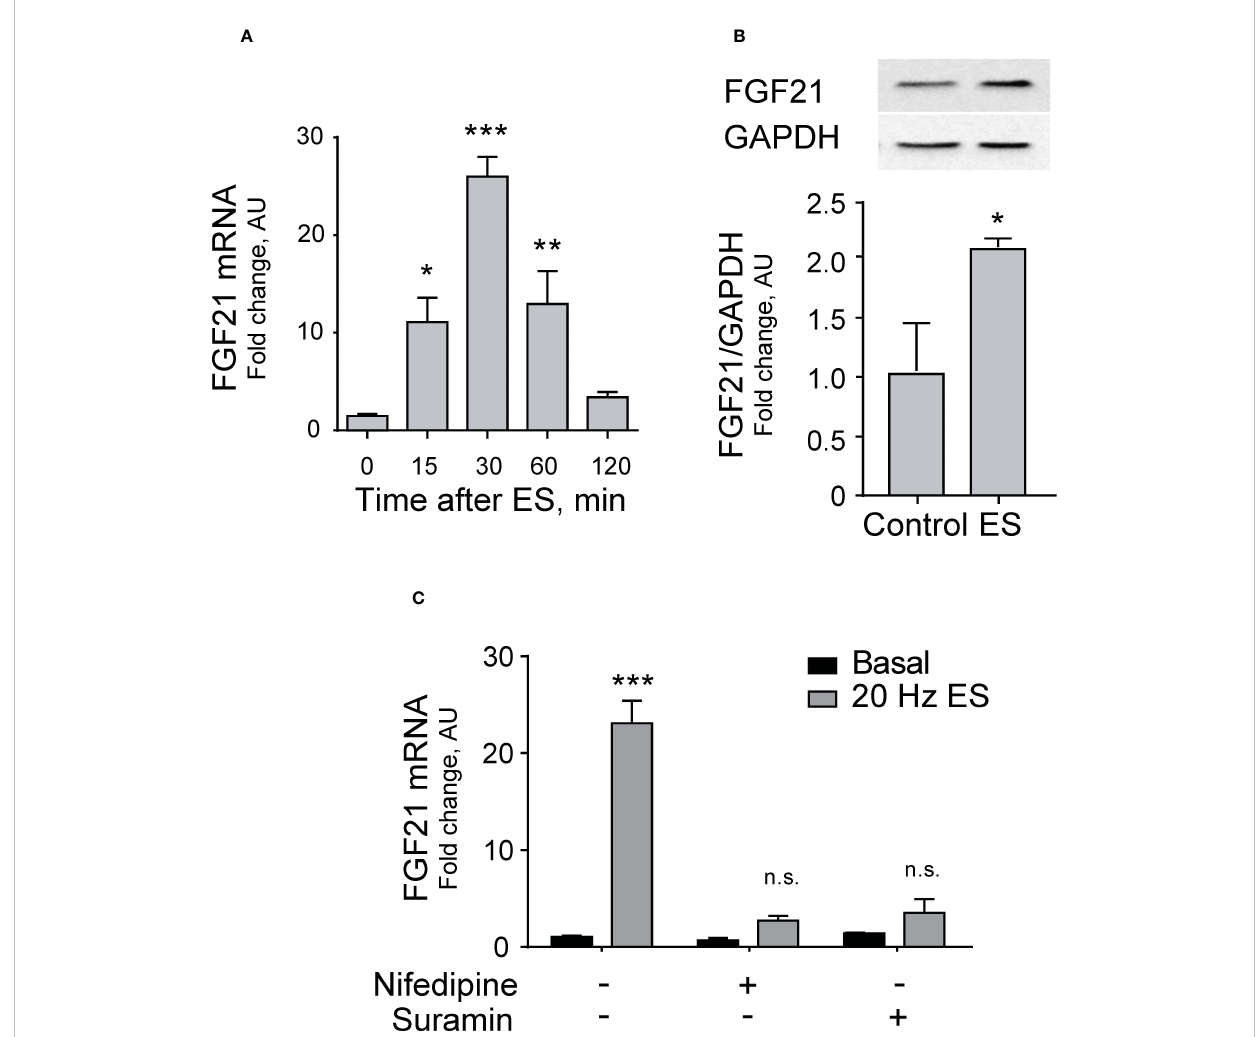
FIGURE 1 Electrical stimulation increases FGF21 expression dependent on the eATP signaling pathway in skeletal muscle. (A) Electrical stimulation (ES, 20 Hz, 270 pulses, 0.3 ms each) evokes a transient increase in FGF21 mRNA levels in FDB isolated muscle fi bers. n=6; *p<0.05; ***p<0.001 vs Control; Kruskal-Wallis with Dunn ’ s post-hoc test. (B) In situ electrical stimulation (20 Hz, 270 pulses, 0.3 ms each) of sciatic nerve evokes an increase in FGF21 protein levels in whole-FDB muscle, 120 min after stimulation. n=4; *p<0.05 vs Control; Mann-Whitney test. (C) Nifedipine (25 m M), a blocker of Cav1.1-pannexin-1 communication, and suramin (100 m M), a non-selective P2Y/P2X receptors antagonist, both reduce the increase in FGF21 mRNA levels evoked by electrical stimulation (20 Hz, 270 pulses, 0.3 ms each), 30 min after stimulation, in FDB isolated muscle fi bers. n=4; n.s., not signi fi cant; ***p<0.001 vs Basal; Kruskal-Wallis with Dunn ’ s post-hoc